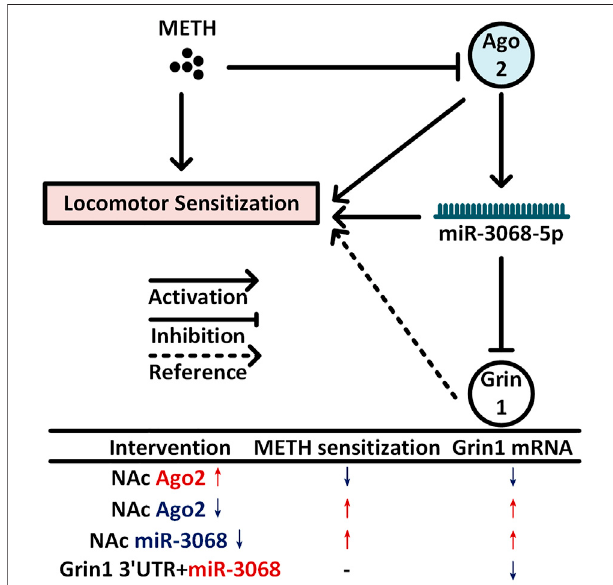
FIGURE 5 | Model for NAc neural Ago2/miR-3068-5p cascades in regulating METH sensitization. METH induces progressive downregulation of Ago2intheNAc.Downregulation ofAgo2may cause asigni fi cantdecrease in miR-3068-5p in the NAc and then contribute to METH sensitization. Grin1 ,encodingacriticalsubunitofNMDAR(Beutleretal.,2011),isapotential downstream gene of miR-3068-5p and may be involved in these effects.